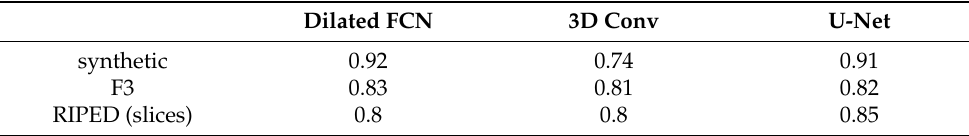
Table 5. Accuracy values of architectures on different datasets.